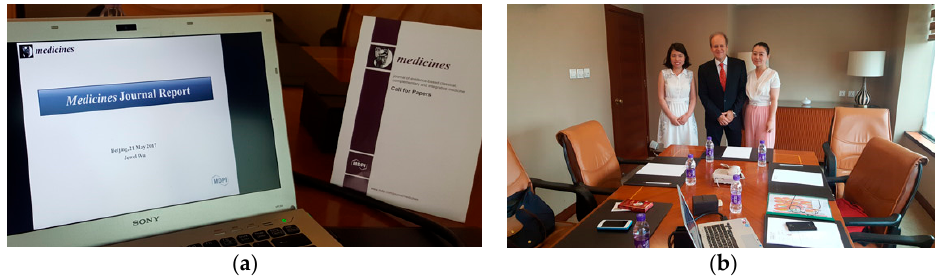
Figure 5. Medicines Editor’s Meeting in Beijing, China, 21 May 2017. Presentation of a report by the Managing Editor Mrs. Jewel Wu ( a ). From left to right: Mrs. Chao Xiao, Section Leader, Professor Gerhard Litscher, Editor-in-chief, and Mrs. Jewel Wu, Managing Editor ( b ).